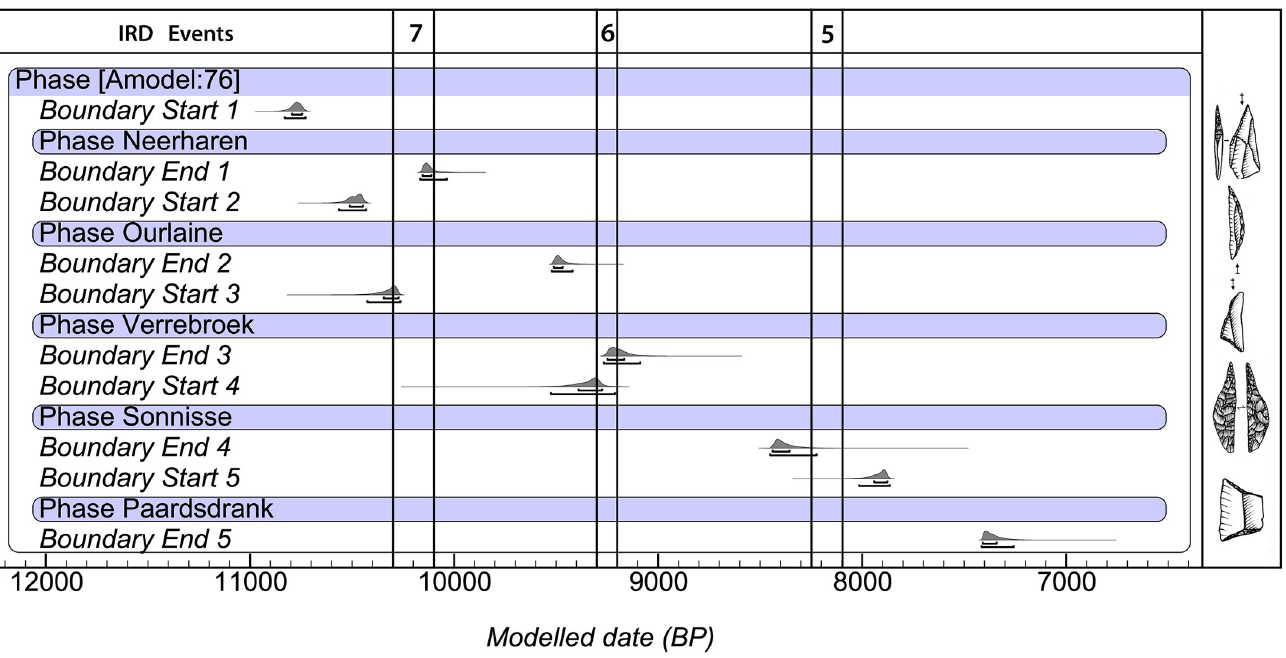
Fig 3. Modelled start and end date of the different ATs and their associated microlithic forms. The chronology of the ERD-events is based on [30–31].